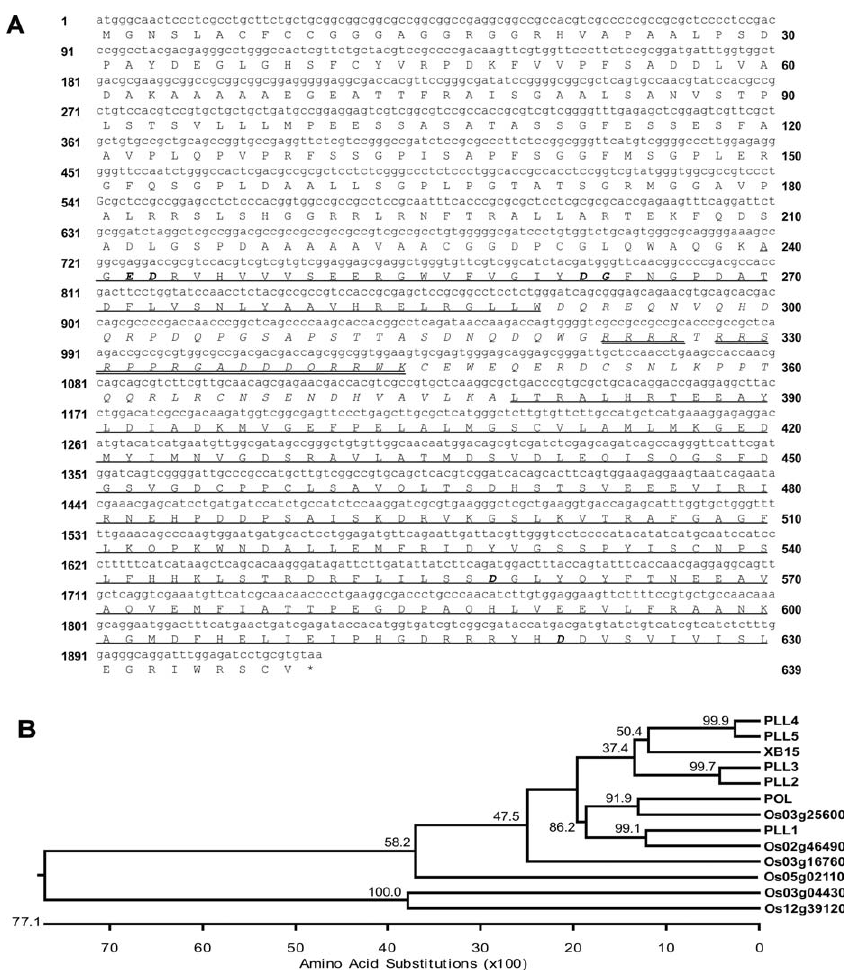
Figure 2. Phylogenetic Relationships among POL and PLL Genes from Rice and Arabidopsis (A) Deduced amino acid sequence of XB15. Italic bold represents residues that interact with metal cofactors in human PP2C a [47]. The PP2C catalytic domain is underlined, and the unique insertion sequence in the PP2C catalytic domain is marked with italics. Predicted nuclear targeting signals are double-underlined (http://www.psort.org/).(B) Phylogenetic analysis at POL and PLLs from Arabidopsis and rice. For determining phylogenetic relationships, protein sequences of the conserved PP2C domains for putative plant proteins related to POL were aligned and then used in ClustalV. Ten thousand bootstrap replicates were performed. Rice PP2Cs with low homology to XB15, Os03g04430, and Os12g39120 were defined as outgroups. Sequences used in this analysis were as follows: POL, PLL1 (AAC3686), PLL2 (NP195860), PLL3 (NP187551), PLL4 (AAL38775), and PLL5 (AAK32783) from Arabidopsis ; and XB15, Os03g60650, Os03g25600, Os02g46490, Os05g02110, and Os03g16760 from rice.